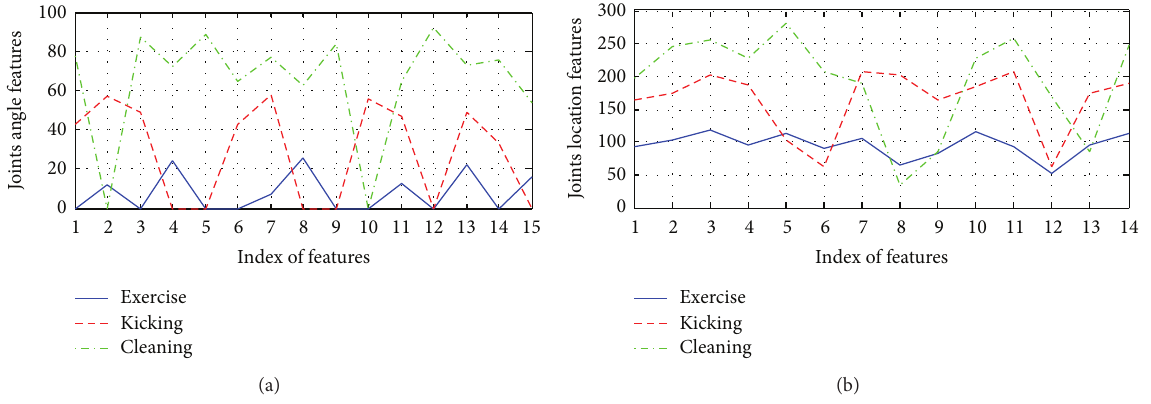
Figure 9: 1D plots of (a) joints angle and (b) joint locations features for exercise, kicking, and cleaning activities.